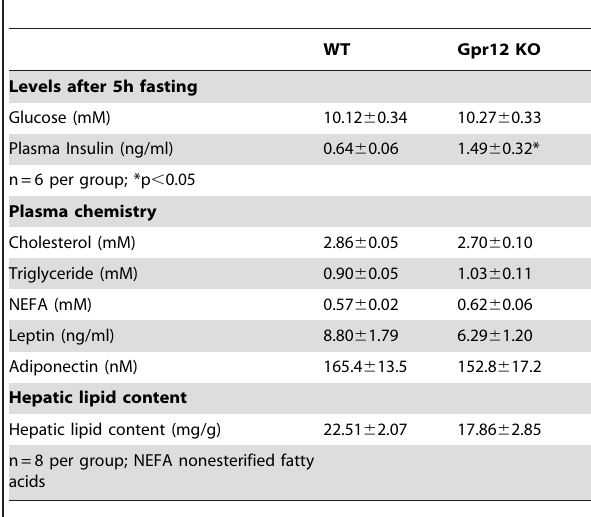
Table 2. Blood chemistry and hepatic lipids of wild type (WT) and Gpr12 deficient (Gpr12 KO) mutant mice – Swedish study.